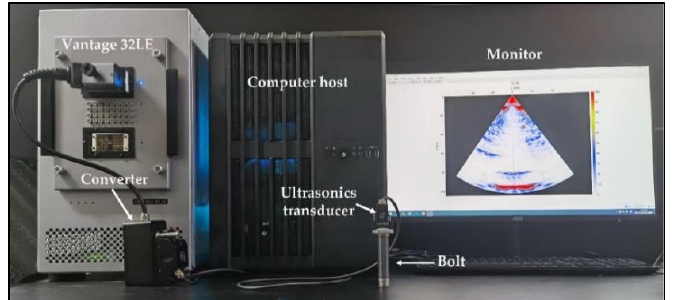
Figure 4. The p hased array ultrasonic S−scan signal acquisition system. Figure 4. The phased array ultrasonic S − scan signal acquisition system. The probe is in direct contact with the end face of the nut. The oil is used as the coupling agent between the probe and the nut to realize the contact detection, ignoring the influence of the coupling agent on the detection results. Make the echo at the bottom of the thread symmetrical about the central axis of the sector image, and take the echo at the bottom of the thread and the sidewall of the bolt in the figure as the reference.